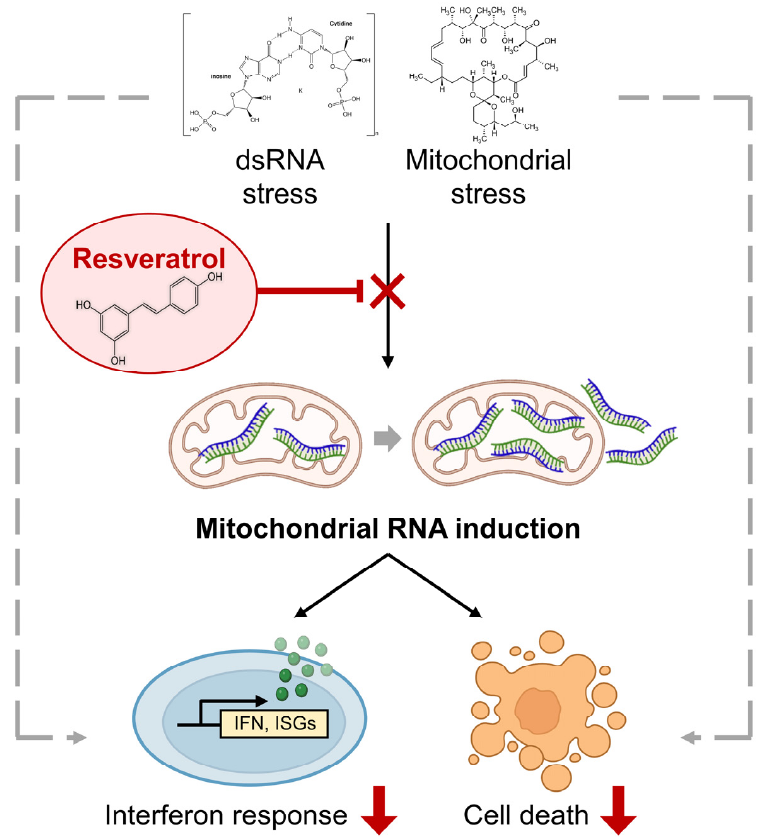
Figure 5. The rescue effect of RES on cellular response to immunogenic stresses. Two immunogenic stressors, poly I:C stimulation and OA, exert their downstream effects partly via mtRNAs. By promoting mitochondrial function and preventing mtRNA induction, an antioxidant RES can counter the molecular and cellular responses to these stressors.